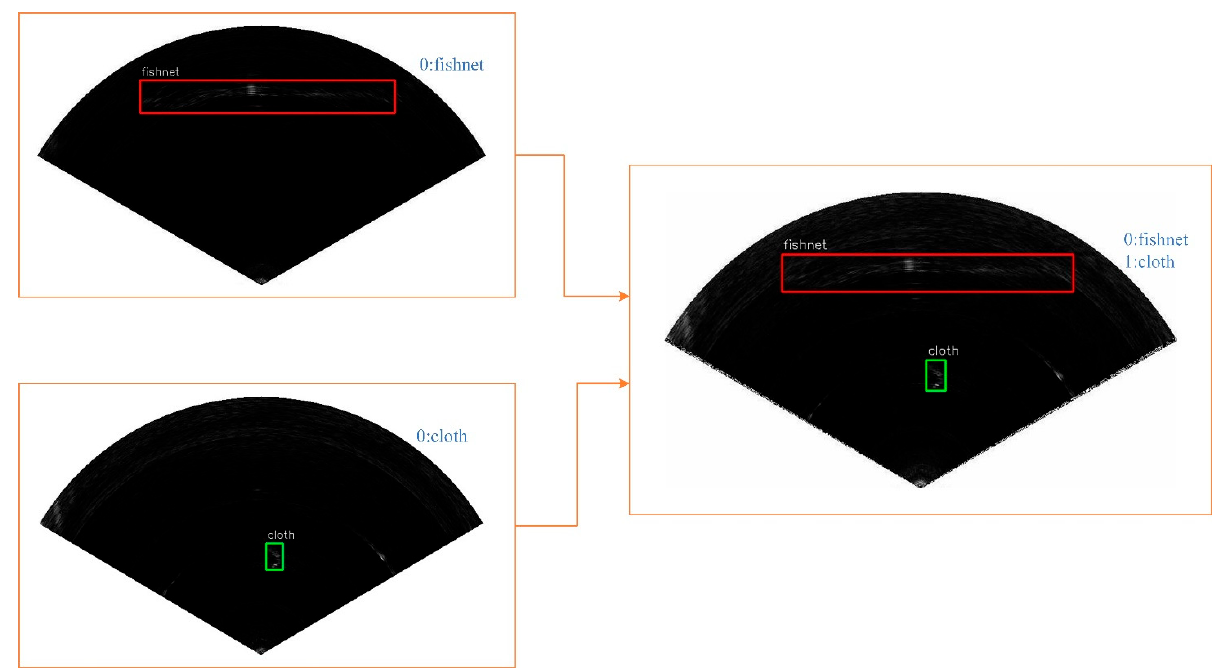
Figure 12. Mixed images for object detection. The images are mixed by pixel, and the bounding box of objects are also merged into the mixed image.